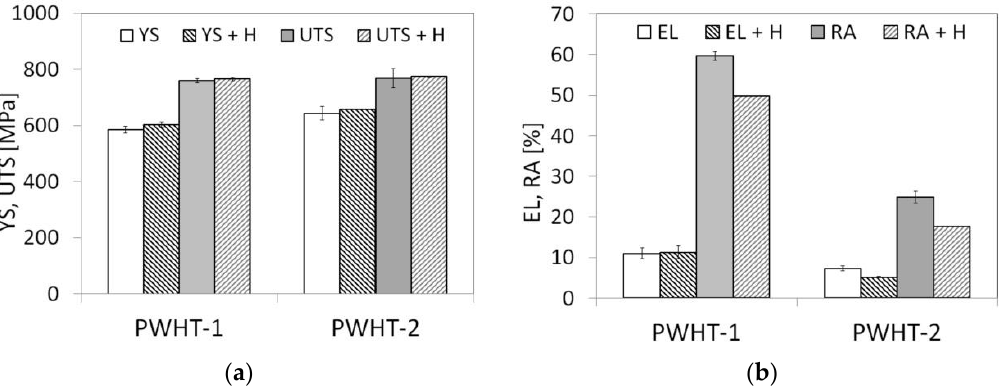
Figure 8. The effects of PWHT conditions and subsequent electrolytic hydrogenation on room-temperature tensile properties of investigated T92/T92 weldments: ( a ) strength properties and ( b ) deformation properties.